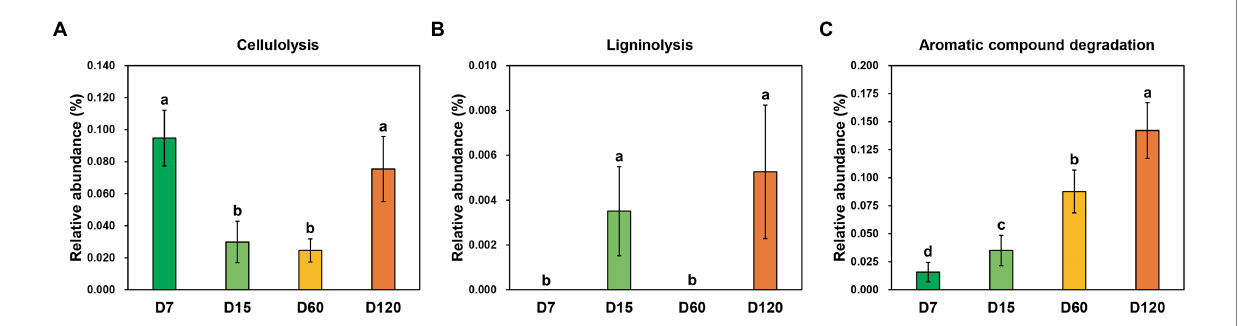
FIGURE 4 Variation of the functional profiles involved in straw decomposition determined by functional prediction. (A) Cellulolysis function. (B) Ligninolysis function. (C) Aromatic compound degradation. Different letters indicate significant differences as checked by the Kruskal-Wallis rank sum test ( p < 0.05).